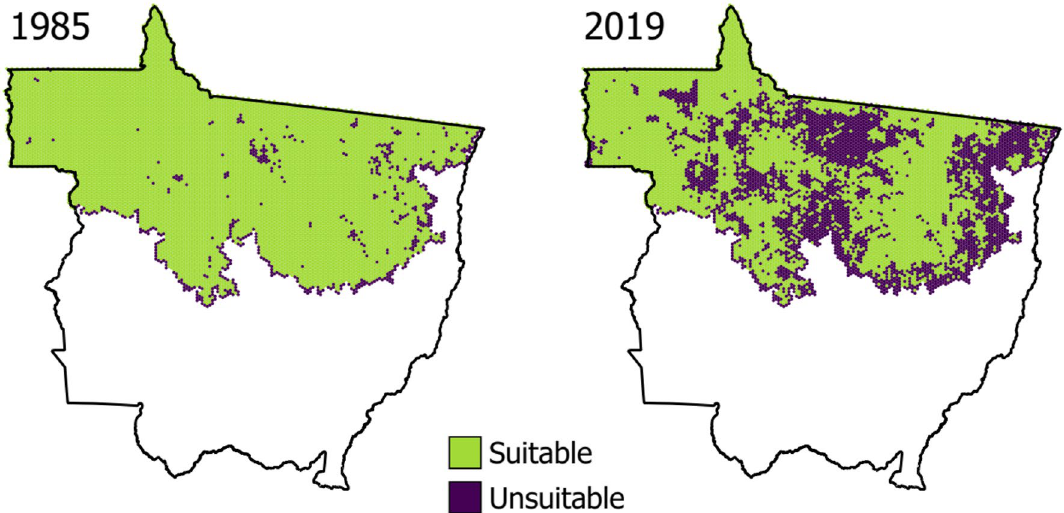
Figure 8. Comparison of cells in northern Mato Grosso containing less than 50% of forest (purple cells indicate unsuitable habitat) along the time series examined in this study, from 1985 (left) to 2019 (right) in a region that was once entirely covered by Amazonian forest. No harpy eagle nests has ever been found in landscapes with less than 30% of forest cover, and pairs attending nests in areas surrounded by 30–50% forest cover where unable to feed nestlings/fledglings into the dependent juvenile phase (see “Results” section). We therefore consider 50% to be the harpy eagle habitat loss threshold in terms of reproductive viability, at least in terms of completing a nesting cycle. We further estimate that 35% of northern Mato Grosso can no longer support reproductively viable populations of harpy eagles (QGIS V.3.16; https:// www. qgis.